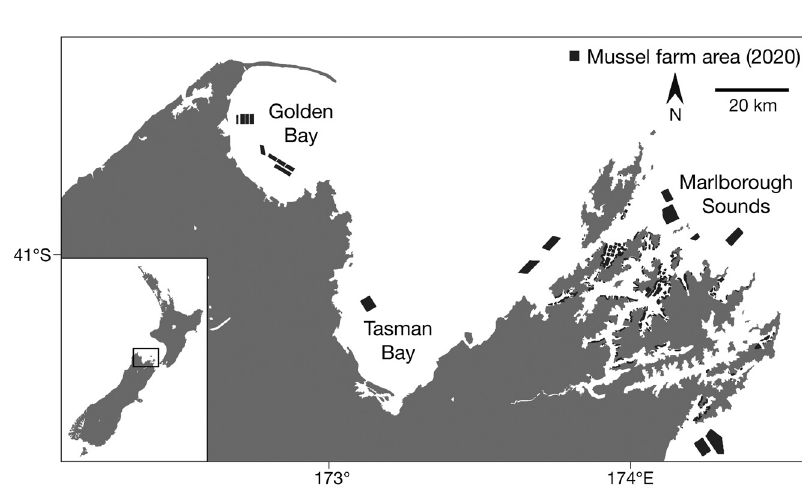
Fig. 1. Study region at the northern end of the South Island of New Zealand. Labels indicate major water bodies analysed for larval supply. Dark grey poly- gons indicate mussel aquaculture sites with harvesting permits in 2020. Only operationally active farms were included in